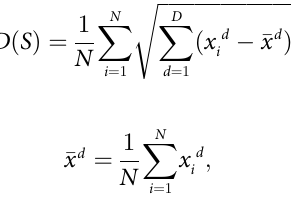
The problem dimension n , the global optimum f min , and the search range are listed in the